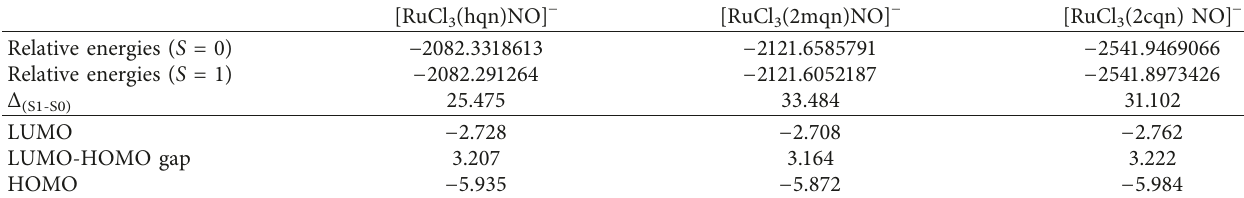
Table 2: Relative energies (kcal/mol) and orbital energies (eV) of HOMOs and LUMOs for [RuCl [RuCl 3 (2cqn)NO] −